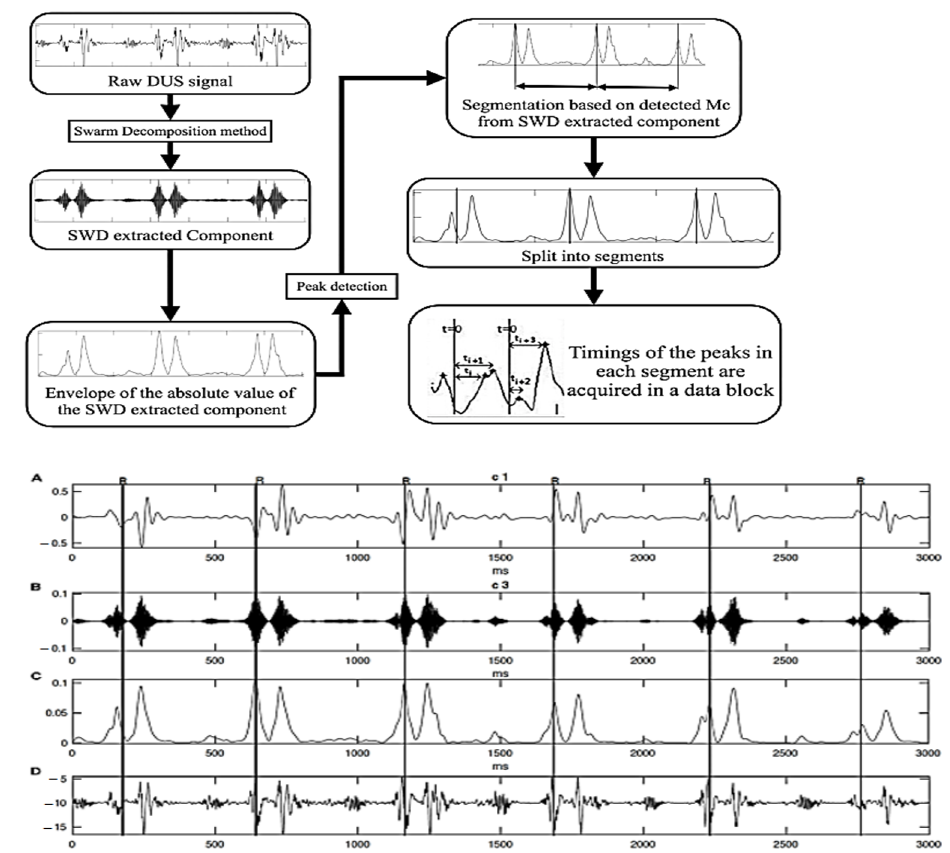
Figure 3. Schematic of the SWARM algorithm technologies [9].